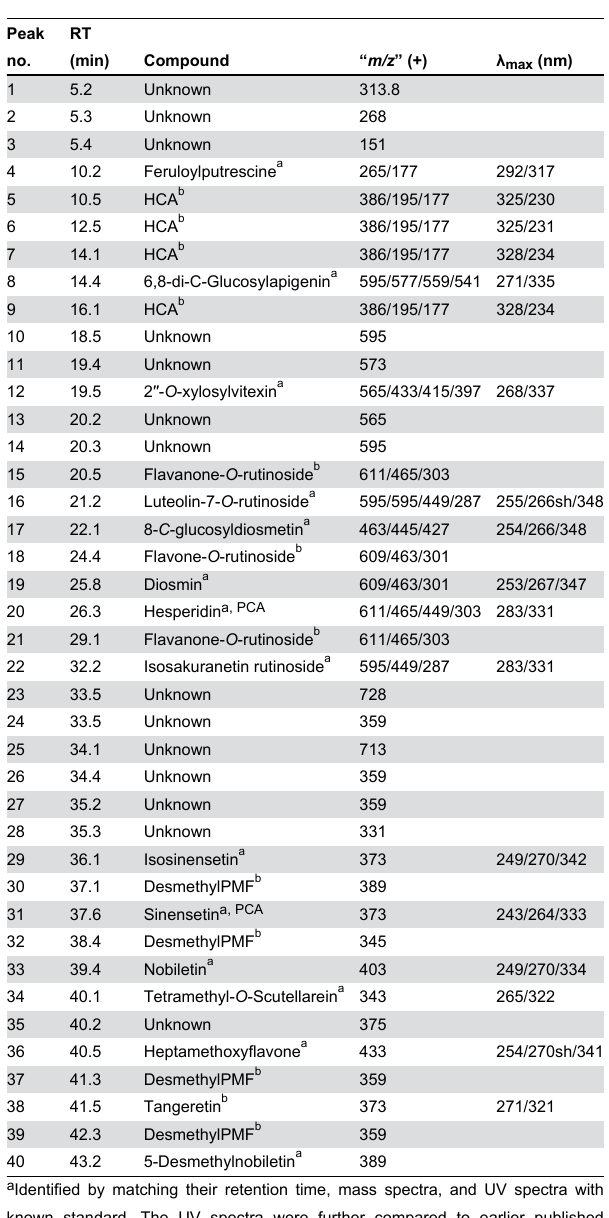
Table 3. APC mass-spectra in positive ion detection mode “ m/z ” and absorbance maximum (nm) for detected